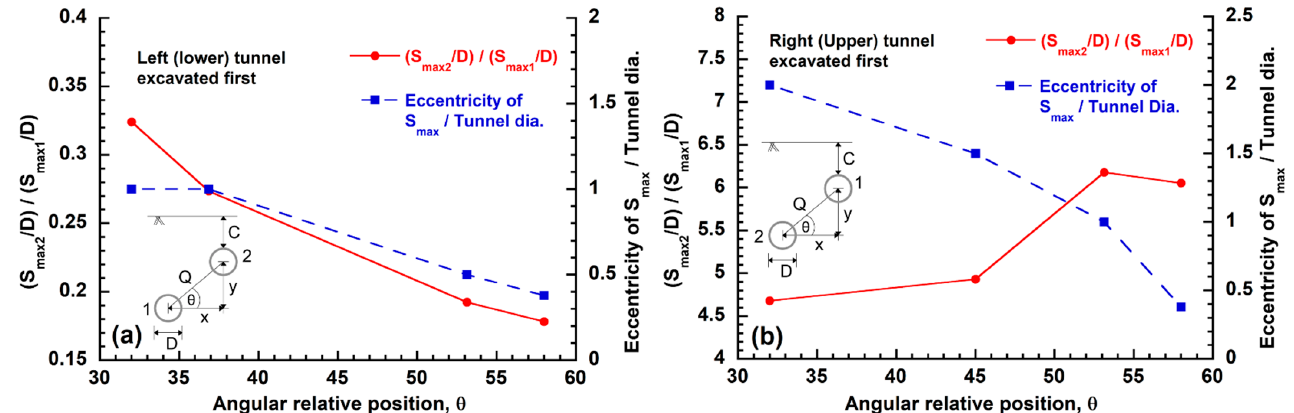
Figure 21. Design chart for preliminary estimation of the ratio of the maximum settlement of the excavated second tunnel to a greenfield tunnel and the eccentricity of the maximum total settlement relative to the center of the new second tunnel. ( a ) Lower tunnel excavated first, ( b ) upper tunnel excavated first.